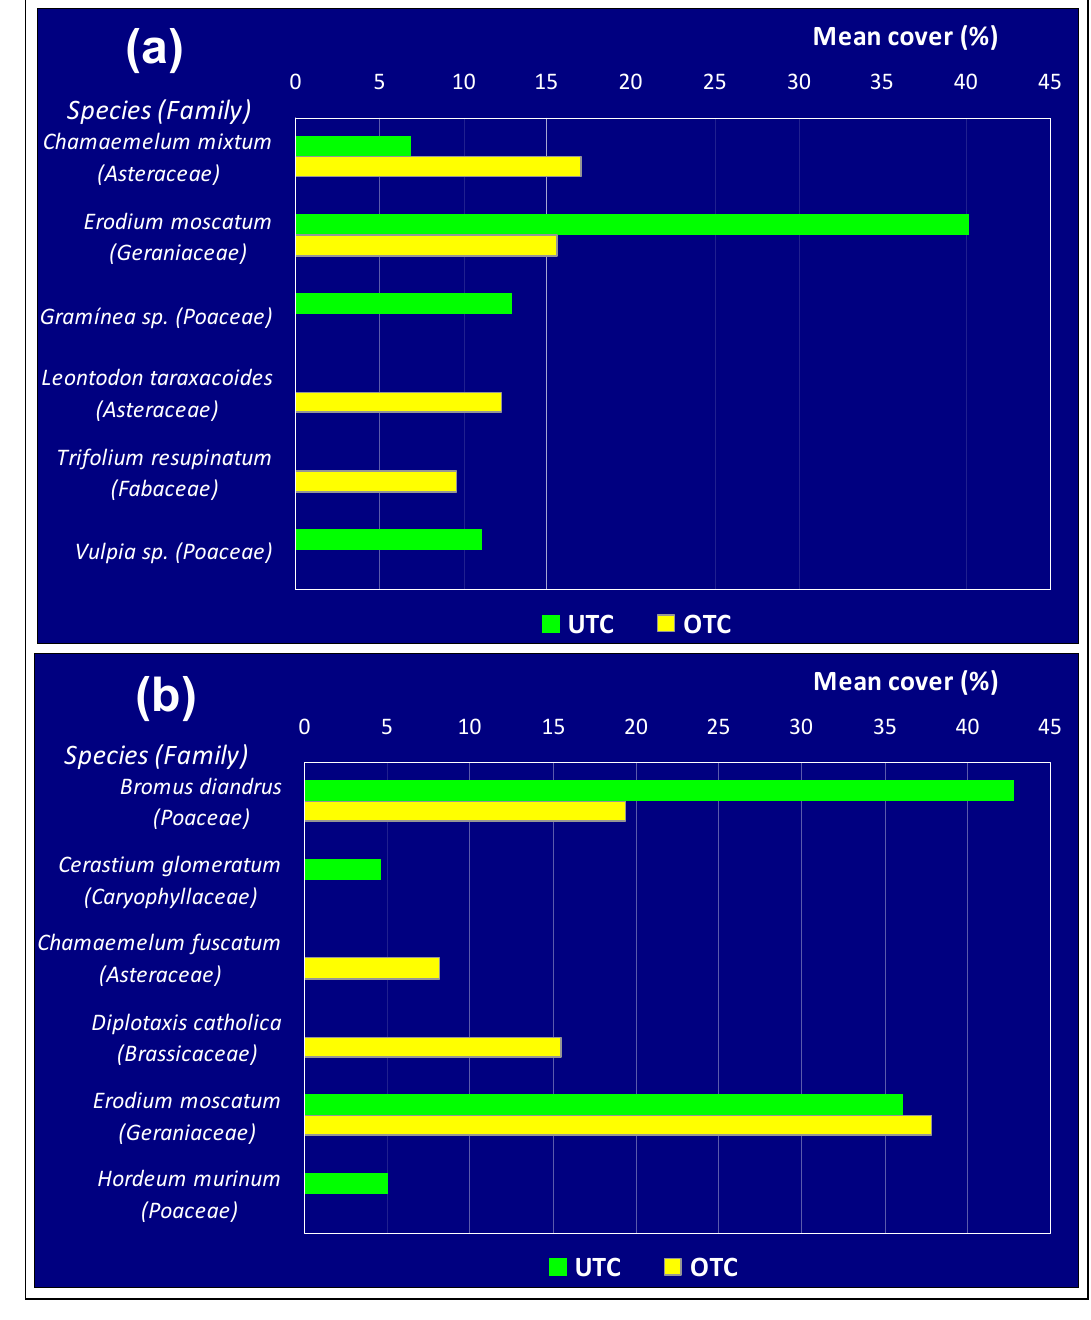
Figure 11. Four predominant botanical species (mean cover, %) of pasture of the studied field in spring 2016 ( a ) and spring 2018 ( b ), under tree canopy (UTC) and outside tree canopy (OTC). In 2016 (before dolomitic limestone application), there was an excessive level of Mn in the soil (see Table 1), leading to a Mg/Mn ratio close to 1, which constitutes a risk of Mn toxicity [1]. Floristic composition results not only from the depressive effect that Mn has on the growth of different species, but also from the competition dynamics between species, thus resulting in an additive effect. There are species that have developed adaptation to excessive levels of Mn, such as Chamaemelium mixtum and Chamaemelium fuscatum , and species that have susceptibility to Mn, which are grasses in general. For example, in spring 2016, the presence of Chamaemelium mixtum is lower UTC (6.9%) than OTC (17.0%), while Gramínea sp. is only present UTC (12.9%). This means that Mn toxicity has been